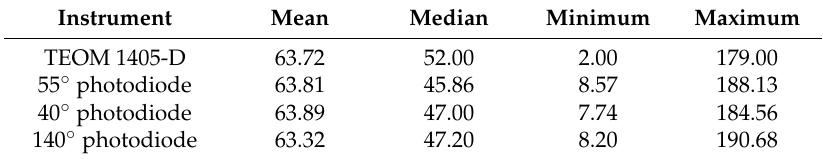
Table 1. Summary of 1-h average PM2.5 measurements ( µ g/m 3 ) by different instruments.